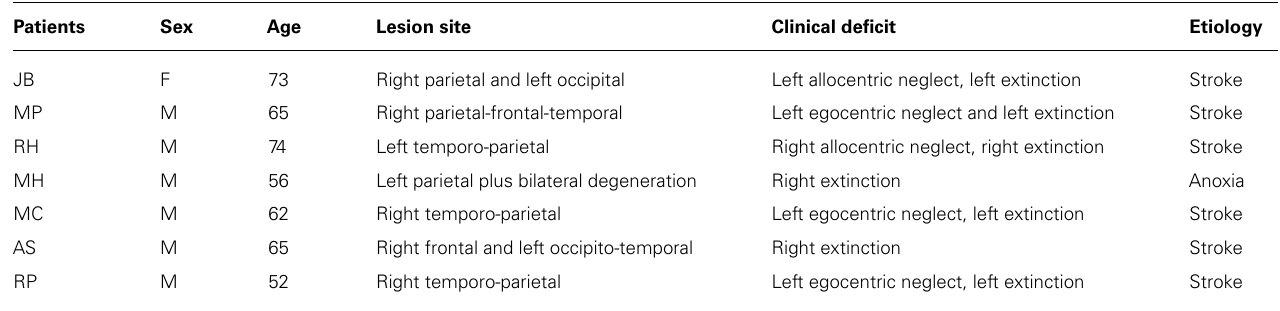
Table 1 | Demographic and clinical details for the